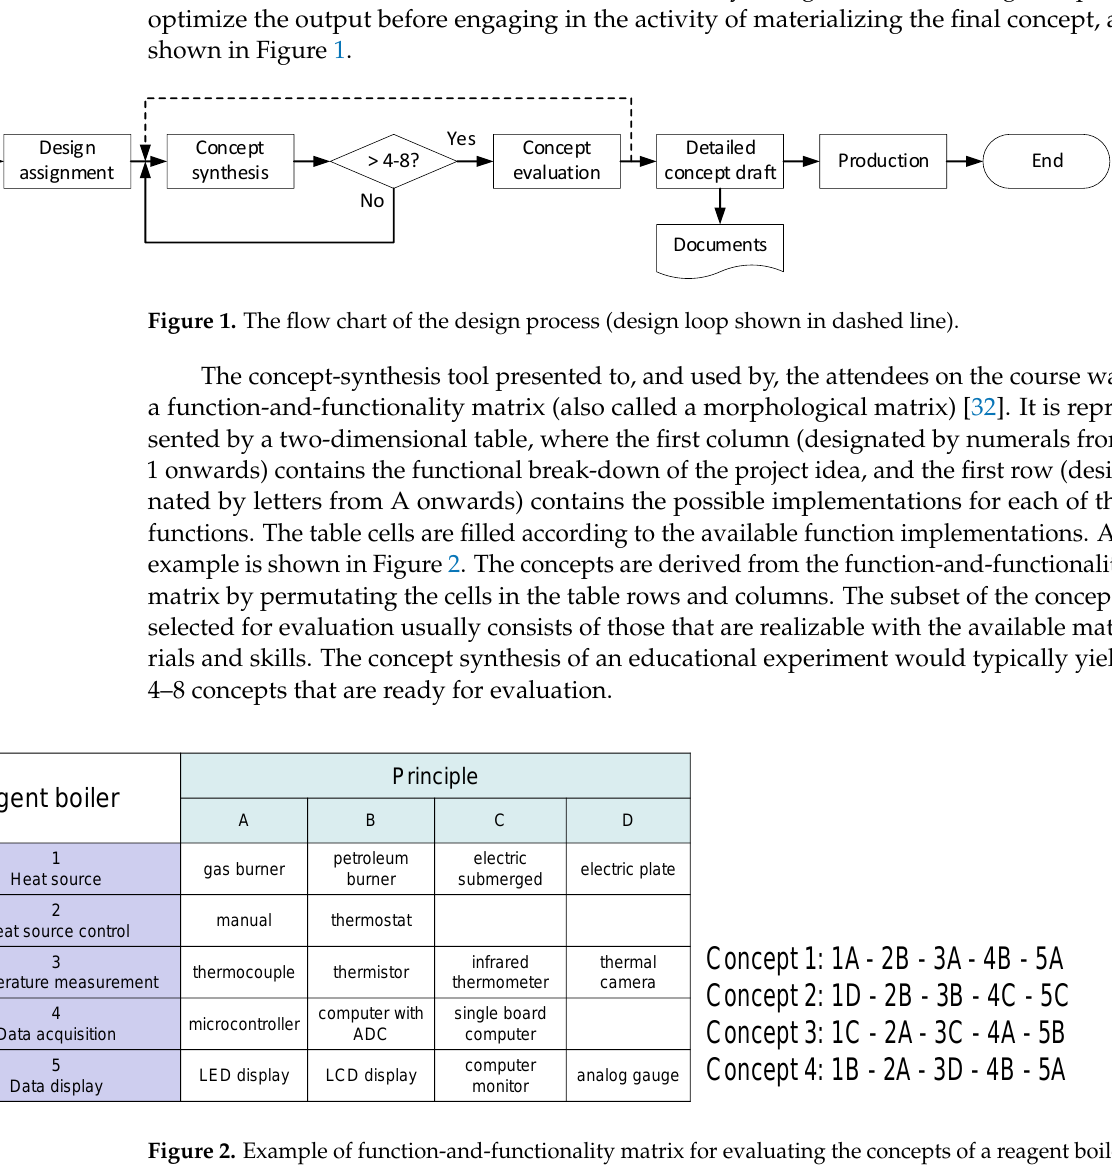
Figure 2. Example of function-and-functionality matrix for evaluating the concepts of a reagent boiler ( left ) and the four synthesized concepts ( right ).